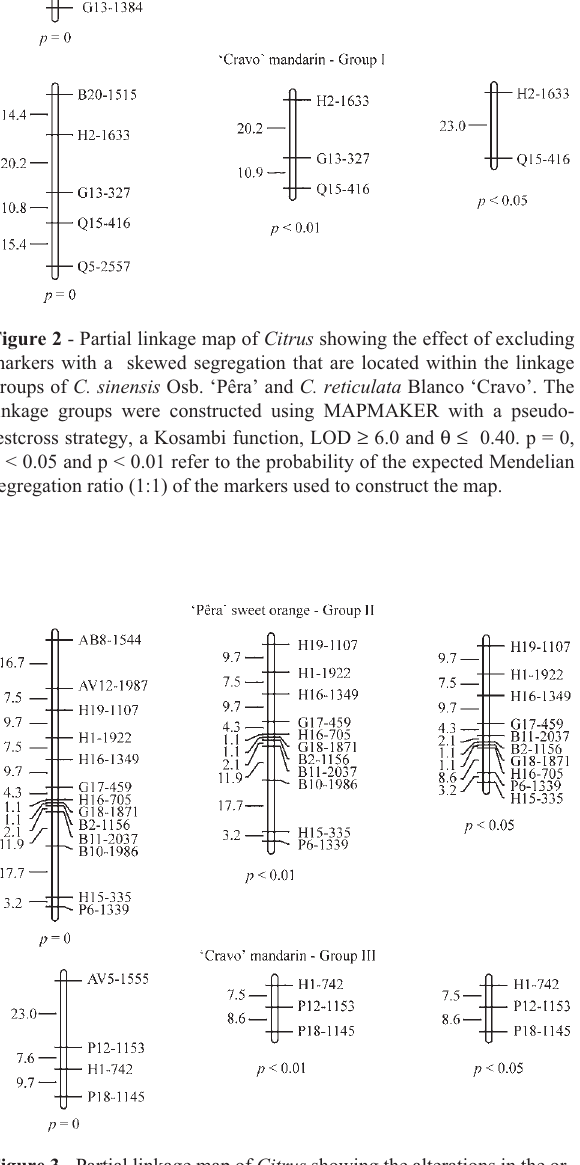
Figure 3 - Partial linkage map of Citrus showing the alterations in the or- der of the markers in the linkage groups of C. sinensis Osb. ‘Pêra’ and C. reticulata Blanco ‘Cravo’ following the exclusion of markers with a skewed segregation. The linkage groups were constructed using MAP- MAKERwithapseudo-testcrossstrategy,aKosambifunction,LOD ≥ 6.0 and θ≤ 0.40. p = 0, p < 0.05 and p < 0.01 refer to the probability of the ex- pected Mendelian segregation ratio (1:1) of the markers used to construct the